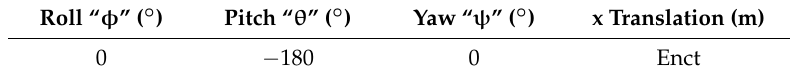
Table 3. Transformation and translation values applied to LiDAR data with a lateral orientation.